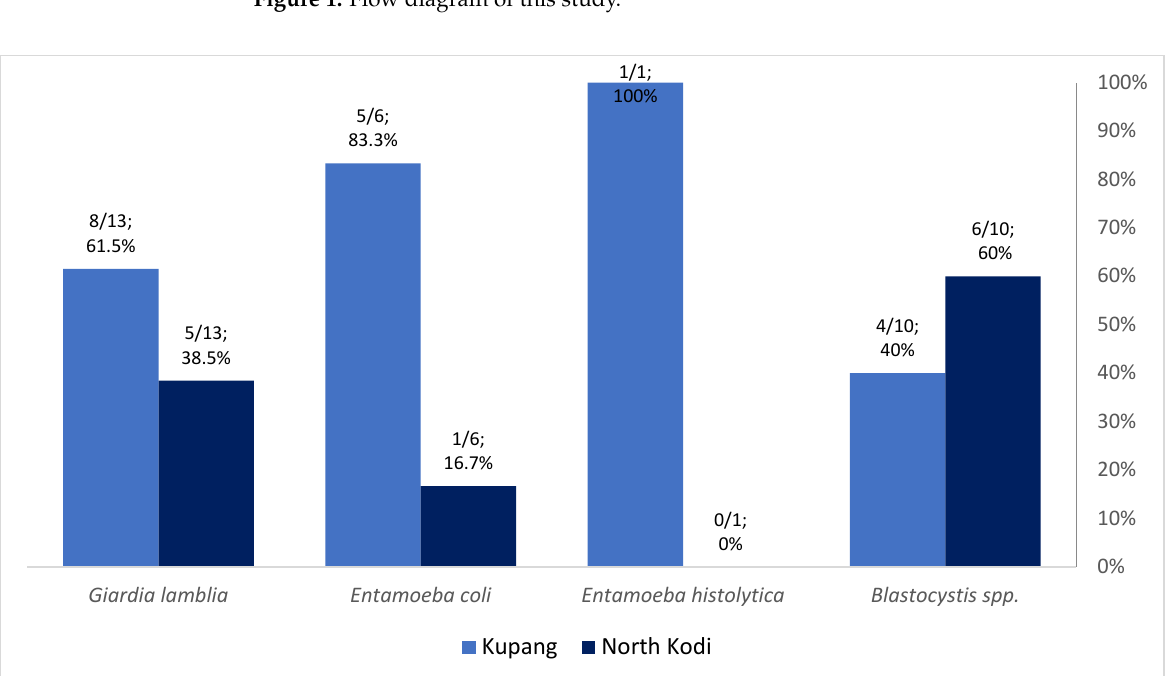
Figure 1. Flow diagram of this study.